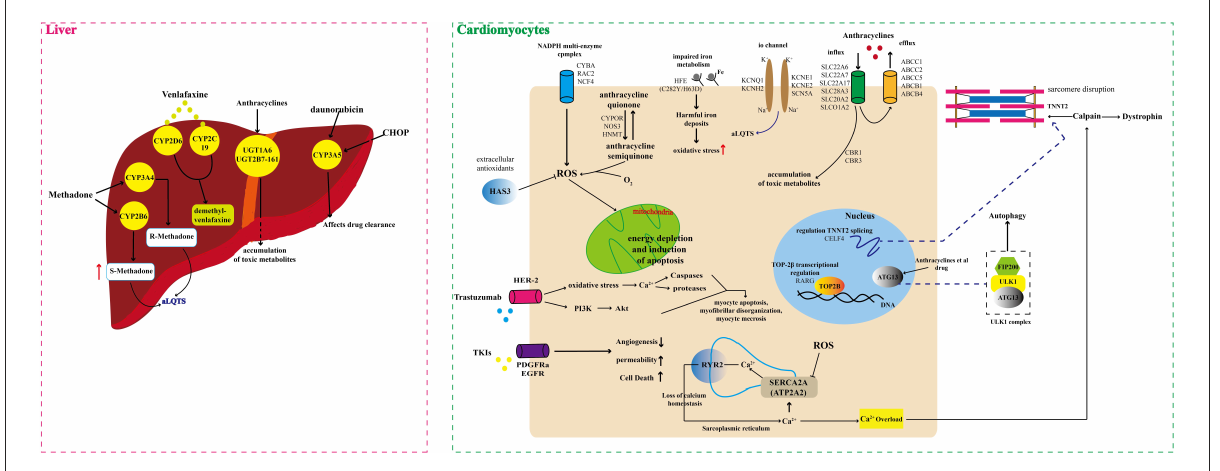
FIGURE1 Schematic illustration of multiple genomic mechanisms of drug